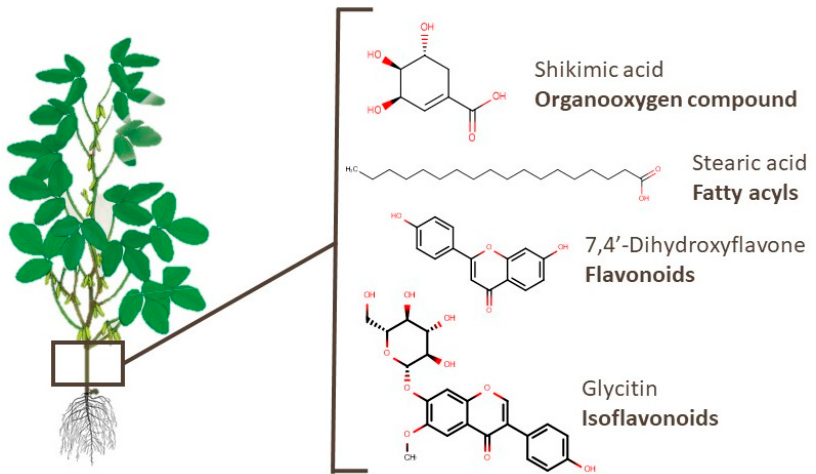
Figure 7. Chemical structures of shikimic acid, stearic acid, 7,4 ′ -dihydroxyflavone, and glycitin, which are examples of bioactive compounds identified in soy branches.